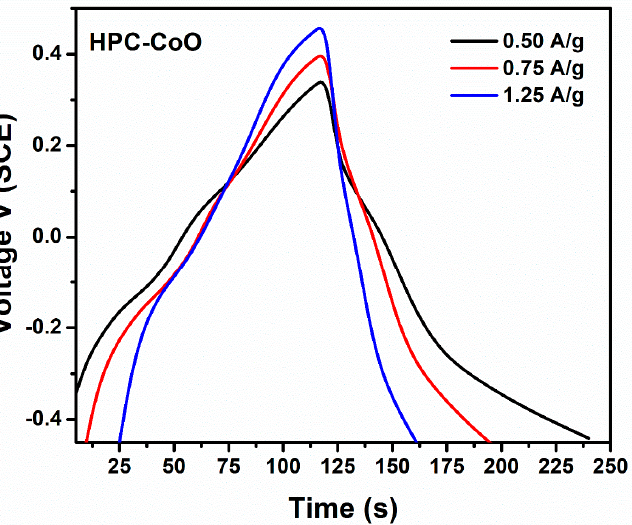
Figure 16. Galvanostatic charge–discharge V-t curves of HPC-CoO (2) at 0.25 A/g, 0.75 mA, and 1.25 A/g current densities.